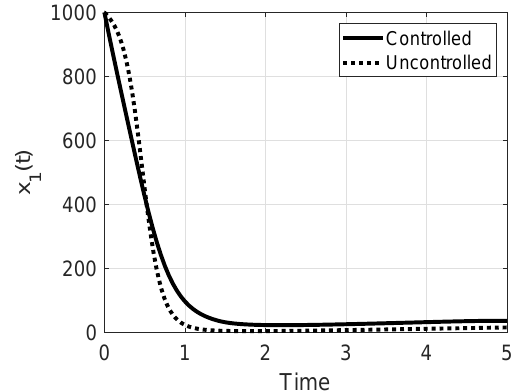
Figure 12. Case 5: evolution of the number of x 1 ( t ) with (continuous line) and without control (dotted line).